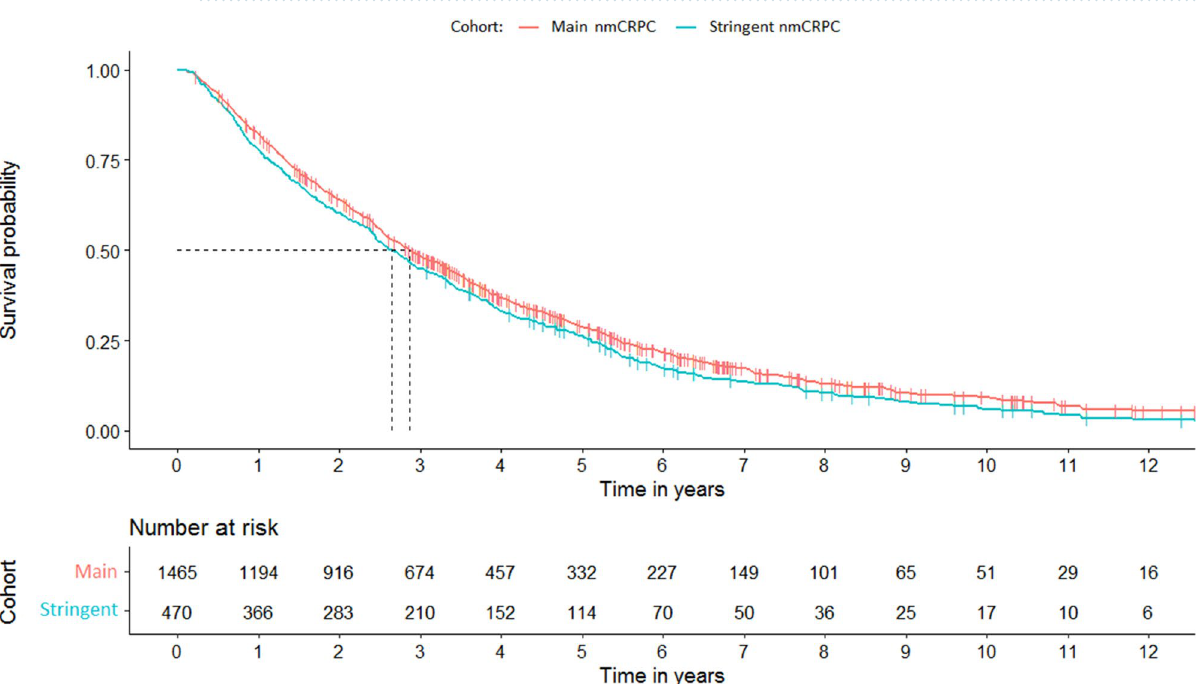
Figure 4. Time from meeting inclusion criteria for the main and stringent nmCRPC cohorts to metastases or death. nmCRPC: non-metastatic castration-resistant prostate